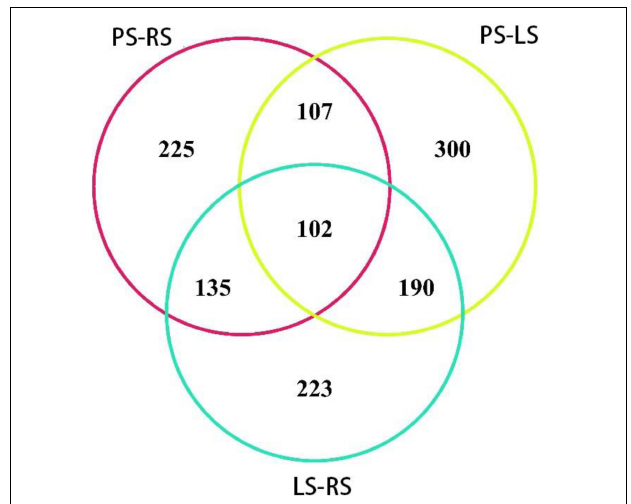
FIGURE 5 | Venn diagram of DAPs from different comparison groups in tobacco root